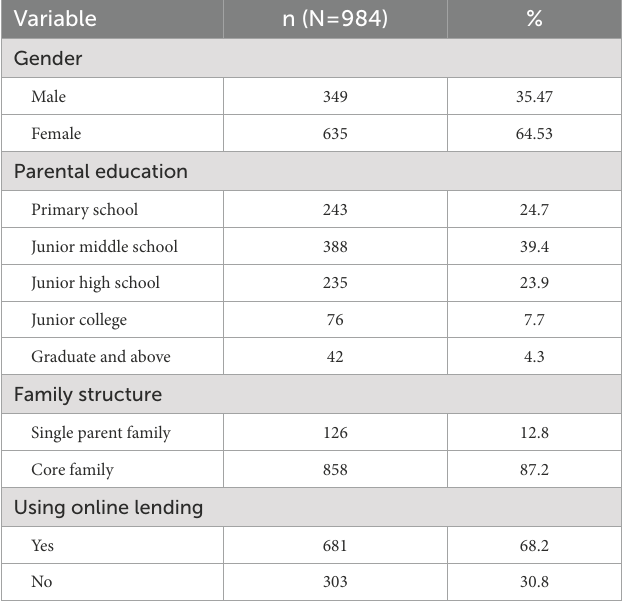
TABLE 1 Descriptive statistics of participants’ demographic information.